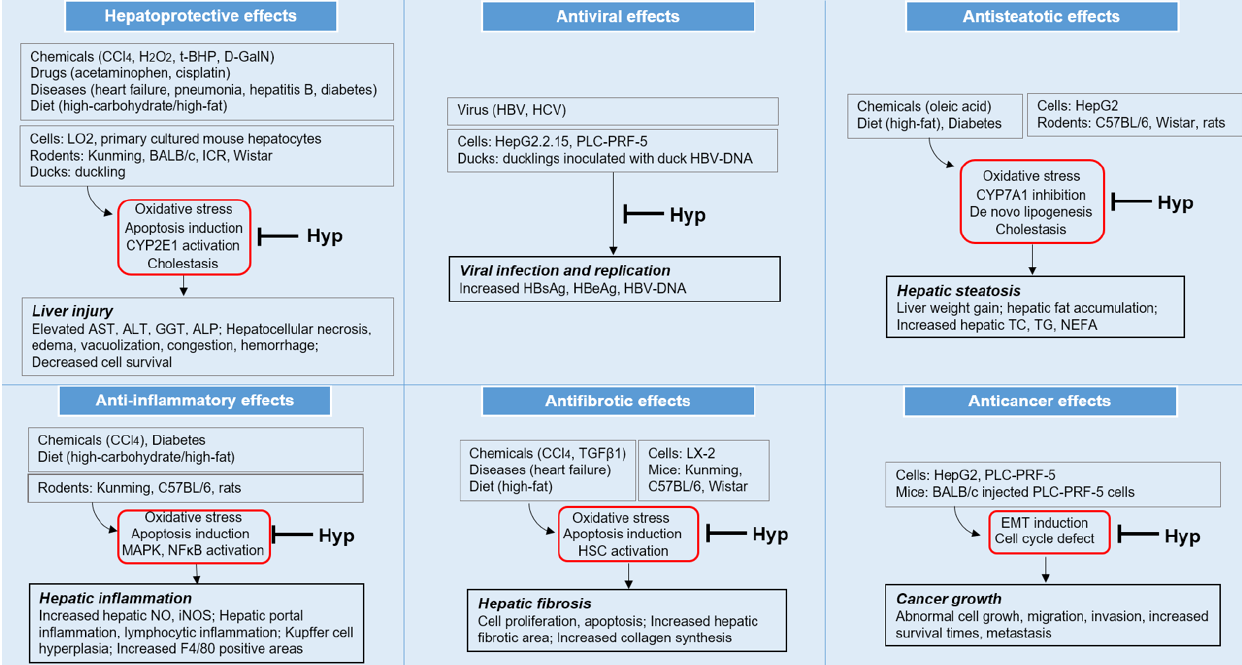
Figure 3. Pharmacological effects and underlying mechanisms of hyperoside (Hyp) in different pathological conditions related to various liver diseases; CCl 4 , carbon tetrachloride; H 2 O 2 , hydrogen peroxide; t-BHP, tert-butyl hydroperoxide; D -GalN, D-galactosamine; CYP, cytochrome P450; AST, aspartate aminotransferase; ALT, alanine aminotransferase; GGT, gamma glutamyl peptidase; ALP, alkaline phosphatase; TC, total cholesterol; TG, triglyceride; NEFA, nonesterified fatty acids; MAPK, mitogen-activated protein kinase; NFκB, nuclear factor kappa -light-chain-enhancer of activated B cells; NO, nitric oxide; iNOS, inducible nitric oxide synthase; HSC, hepatic stellate cell; and EMT, epithelial – mesenchymal transition.